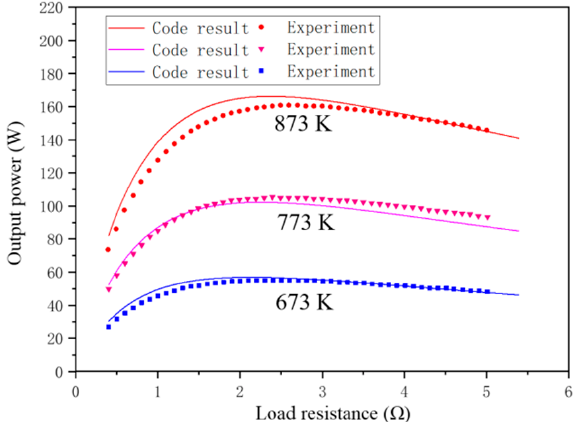
Figure 10. Comparison between the calculated and experimental value of the thermoelectric converter.